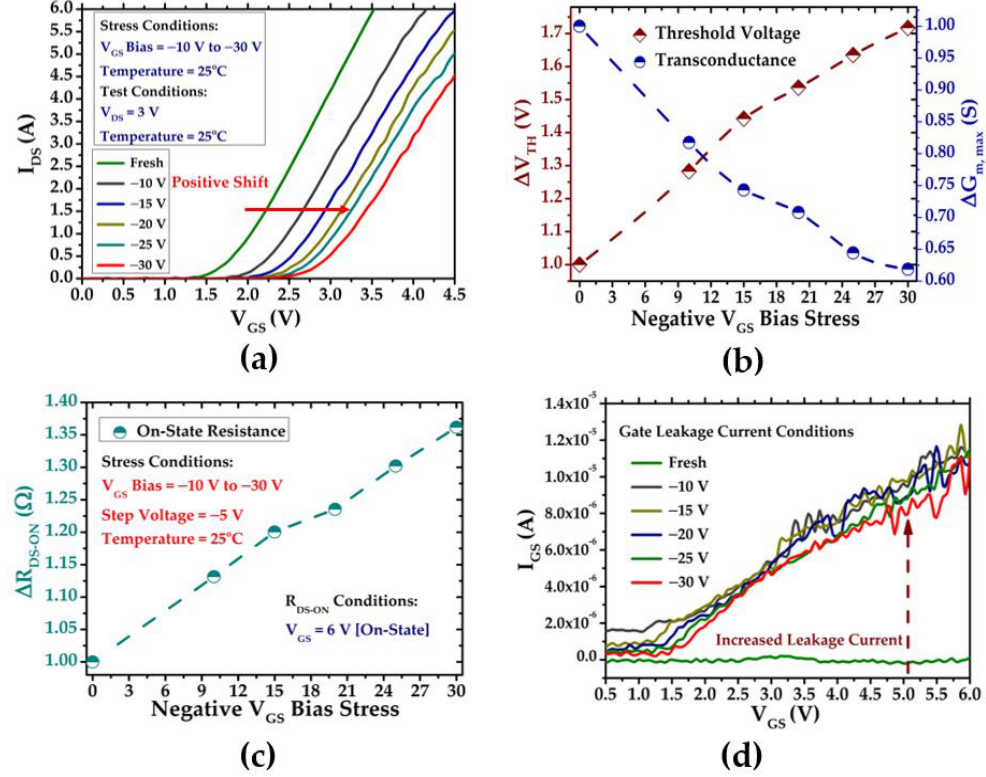
Figure 5. ( a ) Extracted Transfer Characteristics of p-GaN HEMT, ( b ) extracted (cid:52) G m, max and (cid:52) V TH , ( c ) extracted (cid:52) R DS-ON and ( d ) I GS-Leakage under high voltage pulsed stress